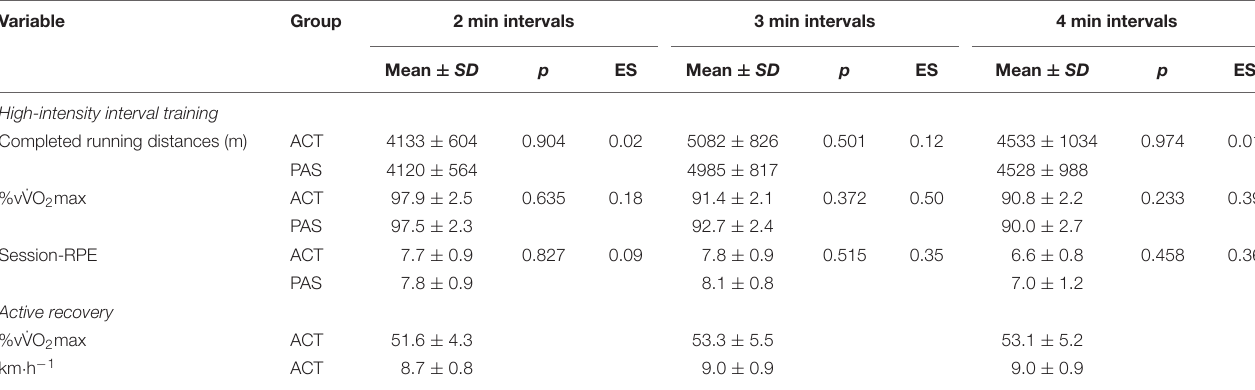
TABLE 5 | Completed running distances, mean running speeds in relation to the velocities at which maximal oxygen consumption occurs (%v˙VO 2 max), and session-rating of perceived exertion (session-RPE) during the 2, 3, and 4 min interval training sessions; differences in completed running distances, %v˙VO 2 max, and session-RPE between the active recovery ( n = 13) and passive recovery ( n = 13) group; %v˙VO 2 max and mean absolute running speeds during active recovery following the 2, 3, and 4 min interval training sessions. Variable Group 2 min intervals